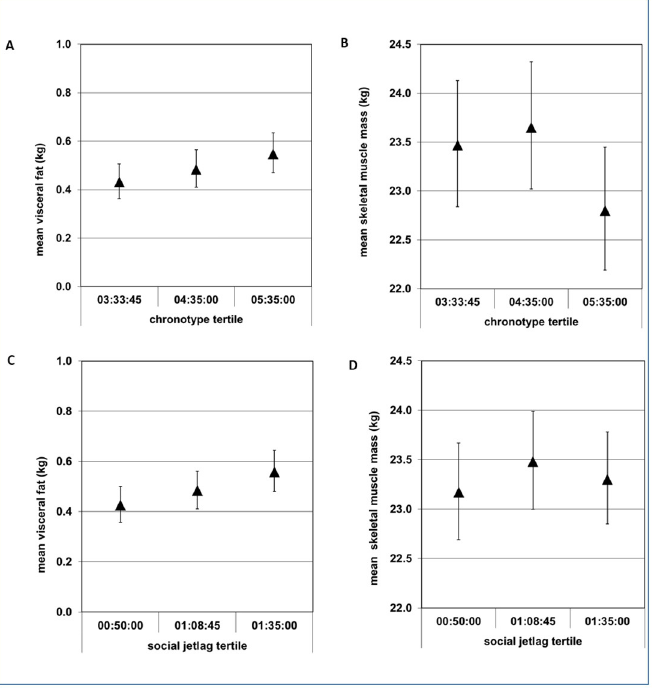
Fig 1. Least square means of body composition measures (95% confidence intervals) by chronotype or social jetlag tertiles: Upper panels: (A) Visceral fat mass (kg) or (B) skeletal muscle mass by tertiles of chronotype. Time in each tertile represents the mean midpoint of sleep—corrected for sleep debt during the week—in the respective tertile. P for trend = 0.048 in (A) and = 0.021 in (B). Lower Panels: (C) visceral fat mass (kg) or (D) skeletal muscle mass by tertiles of SJL. Time in each tertile represents the mean SJL. P for trend = 0.011 in (C) and = 0.869 in (D). Models in panel (A) and (C) are least-square means adjusted for age, sex, and living in shared apartments. Models in (B) and (D) are adjusted for age, sex and height. P-values refers to the value obtained from the multivariable regression model using chronotype or social jetlag as a continuous